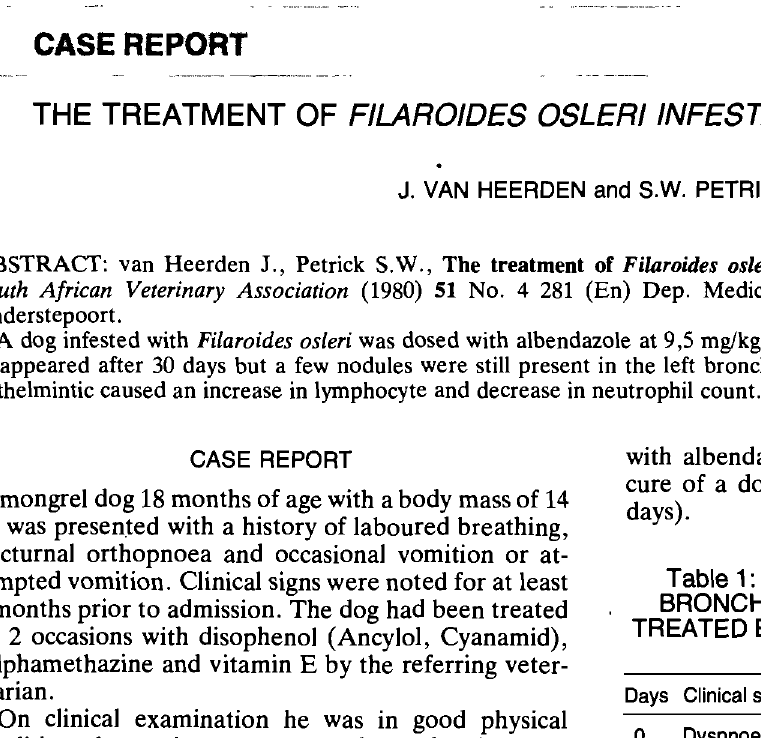
Table 1: CHANGES IN CLINICAL SIGNS AND